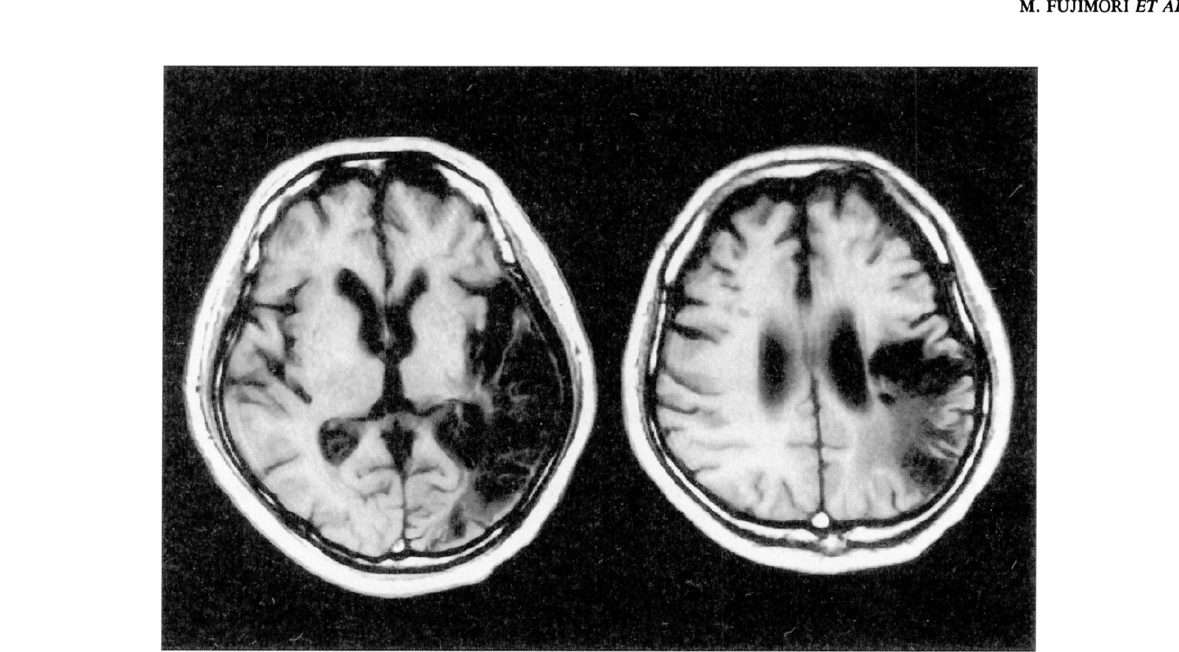
FIG. 1. Cranial magnetic resonance T1-weighted images 5 years after onset demonstrated a left temoro-parietal infarction.